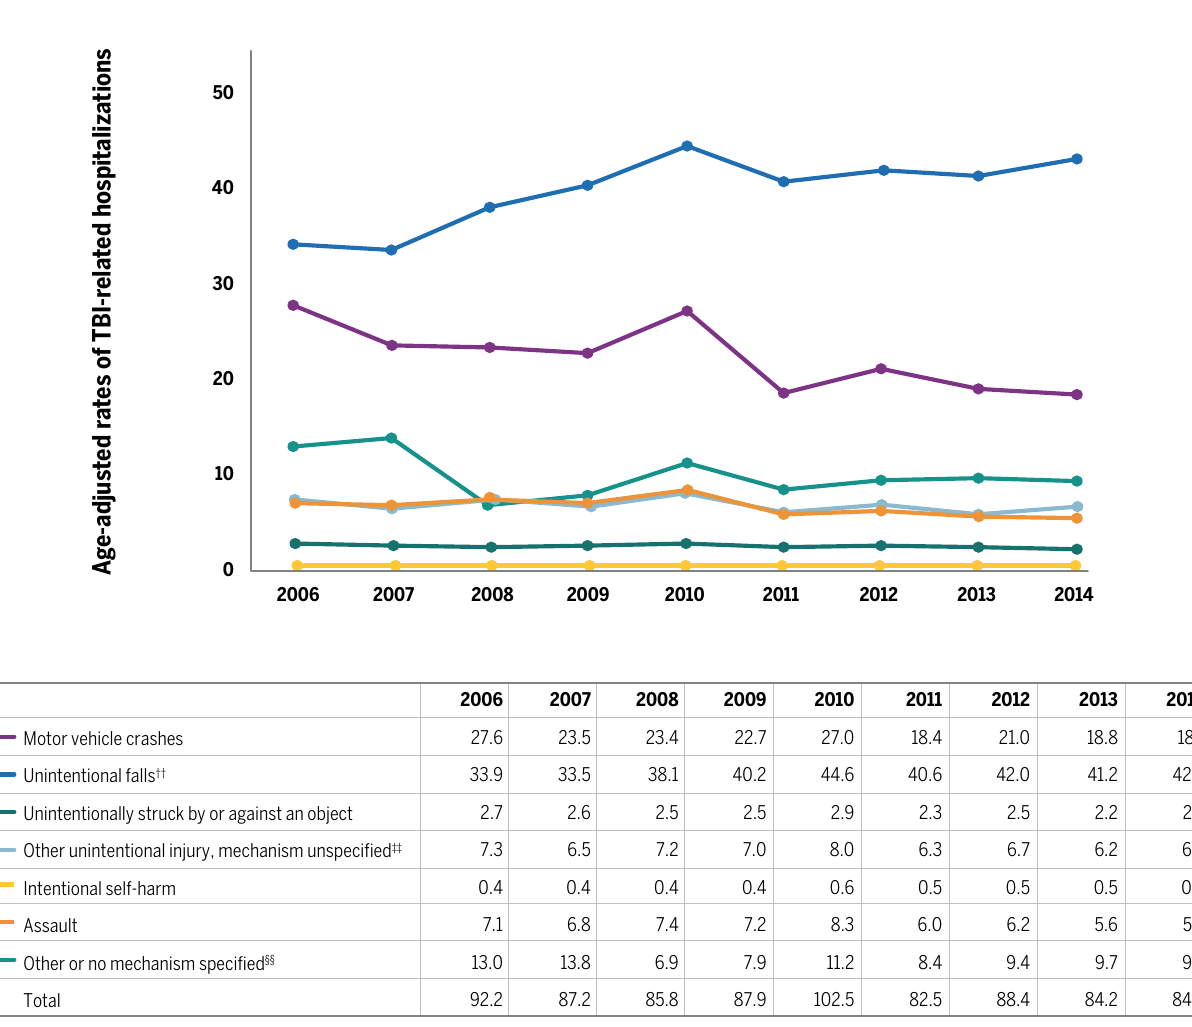
FIGURE 3A: ESTIMATED AGE-ADJUSTED RATES ¶ , PER 100,000 POPULATION, OF TRAUMATIC BRAIN INJURY– RELATED HOSPITALIZATIONS, BY YEAR AND MECHANISM OF INJURY,